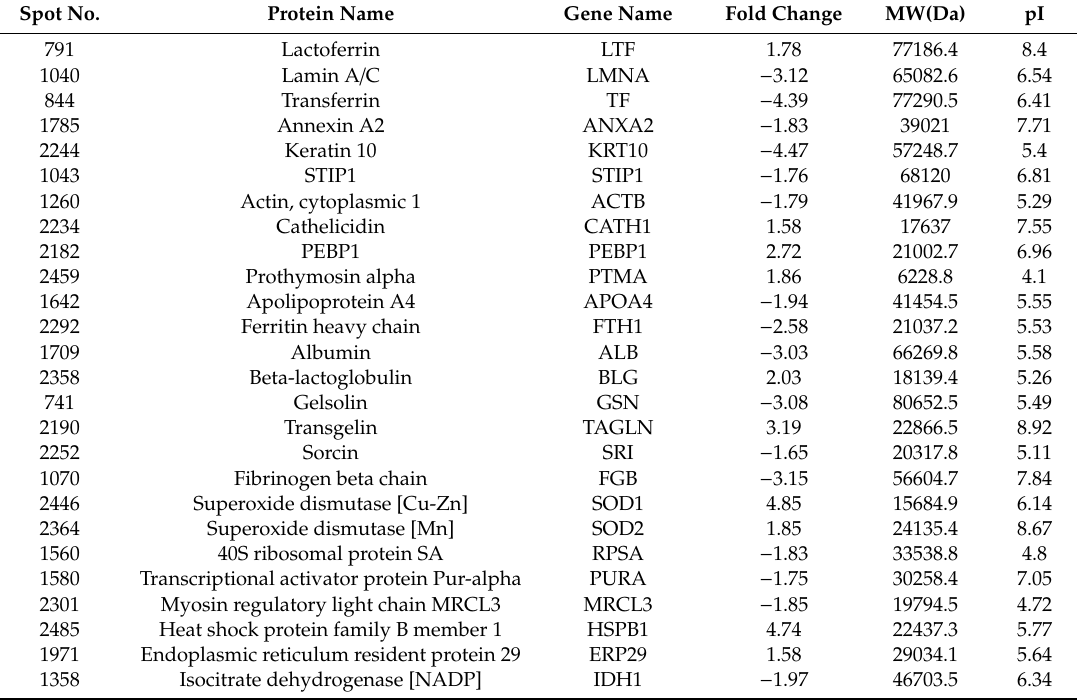
Table 2. Di ff erentially expressed proteins were identified by matrix assisted laser desorption ionization-time of flight mass spectrometry (MALDI-TOF-TOFMS) in mammary tissues with clinical mastitis (CMMTs) as compared with healthy mammary tissues (HMTs). Spot